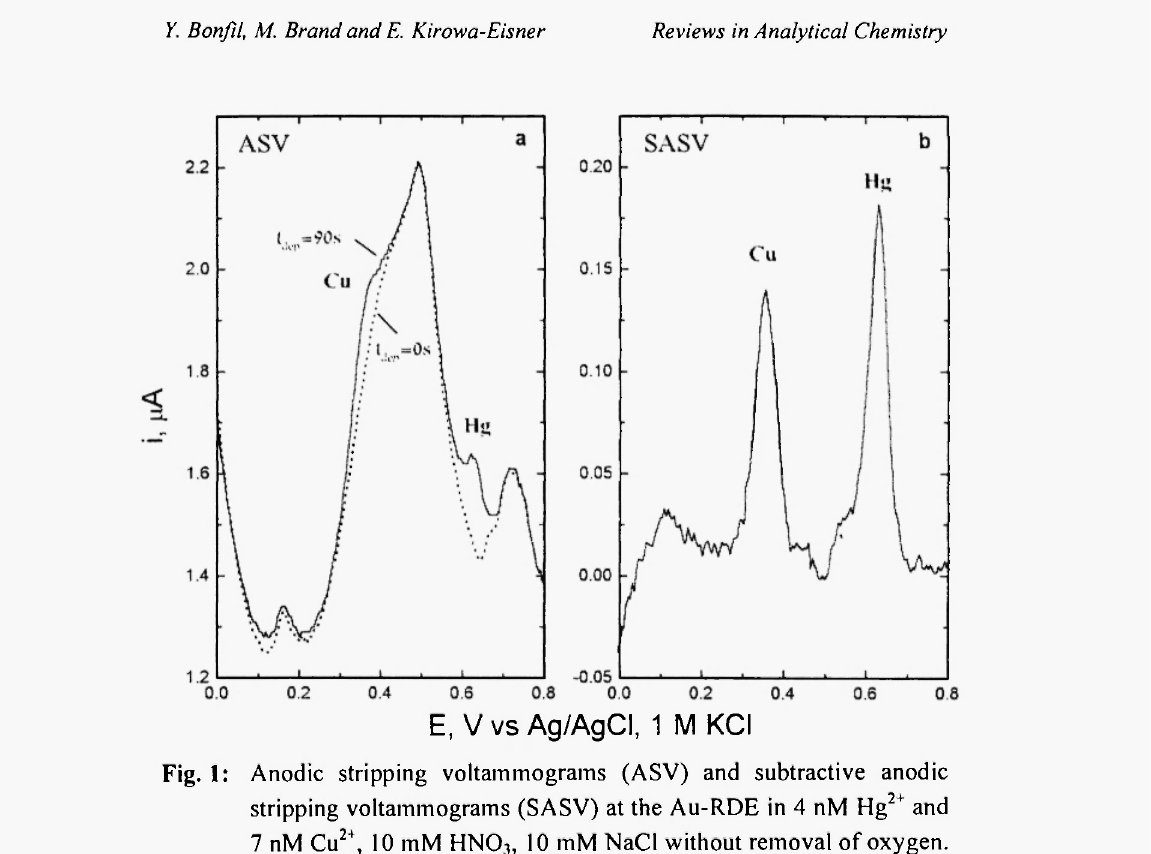
Fig. 1: Anodic stripping voltammograms (ASV) and subtractive anodic stripping voltammograms (SASV) at the Au-RDE in 4 nM Hg 2+ and 7 nM Cu 24 , 10 mM HN0 3 , 10 mM NaCl without removal of oxygen. Condition of electrodeposition: E dep , -0.4 V; 5000 rpm. (a) Full line - ASV, t dcp , 90 s; dotted line - pseudo background, t dep , 0 s. (b) SASV represent the subtraction of the pseudo background from the ASV at t dep , 90 s. SW mode: square-wave amplitude 10 mV; step amplitude 2.5 mV; frequency, 25 Hz. Activation of the electrode: according to section